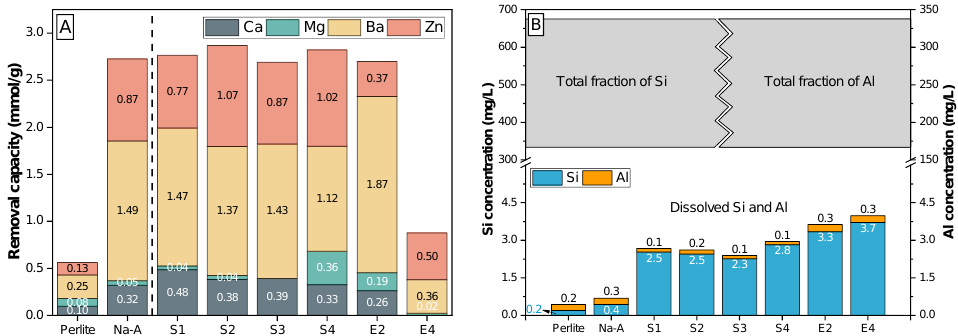
Figure 7. ( A ) Removal capacity for Ca 2+ , Mg 2+ , Ba 2+ and Zn 2+ ions by synthetic GIS- (E2), SOD- (E4) and LTA-zeolites (S1–S4) from a multi-component waste solution ( ∼ 4 mmol/L of Me 2+ ; pH ∼ 6; 25 °C). Perlite powder and commercial zeolite A (Na-A) are included as a reference. ( B ) The low concentrations of dissolved Al and Si measured at ion exchange equilibrium with the acidic multi- component waste solution, relative to the high amounts of solid perlite and zeolite-related Al and Si added to system (grey box), indicate the strong chemical resistance of the synthesized zeolites. In total, less than 2% of the materials was